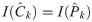
Influence shift diagram of Buzznet, containing n = 101, 163 nodes and m = 2, 763, 066 edges.I(C^k)=I(P^k), for the balance point k = 3, 472. (a) Using the node-normalized scale, the balance point k = 3.4% is far to the left and it is hard to study how the core and periphery influence each other around it. (b) In the plot with the normalized influence scale (under the edge-based interpretation) the balance point is right at the center, while the third plot with a logarithmic scale (c) hints at the asymptotic behavior k = n0.707. The balance point is marked by a grey line and the red dot marks the maximum number of crossing edges.